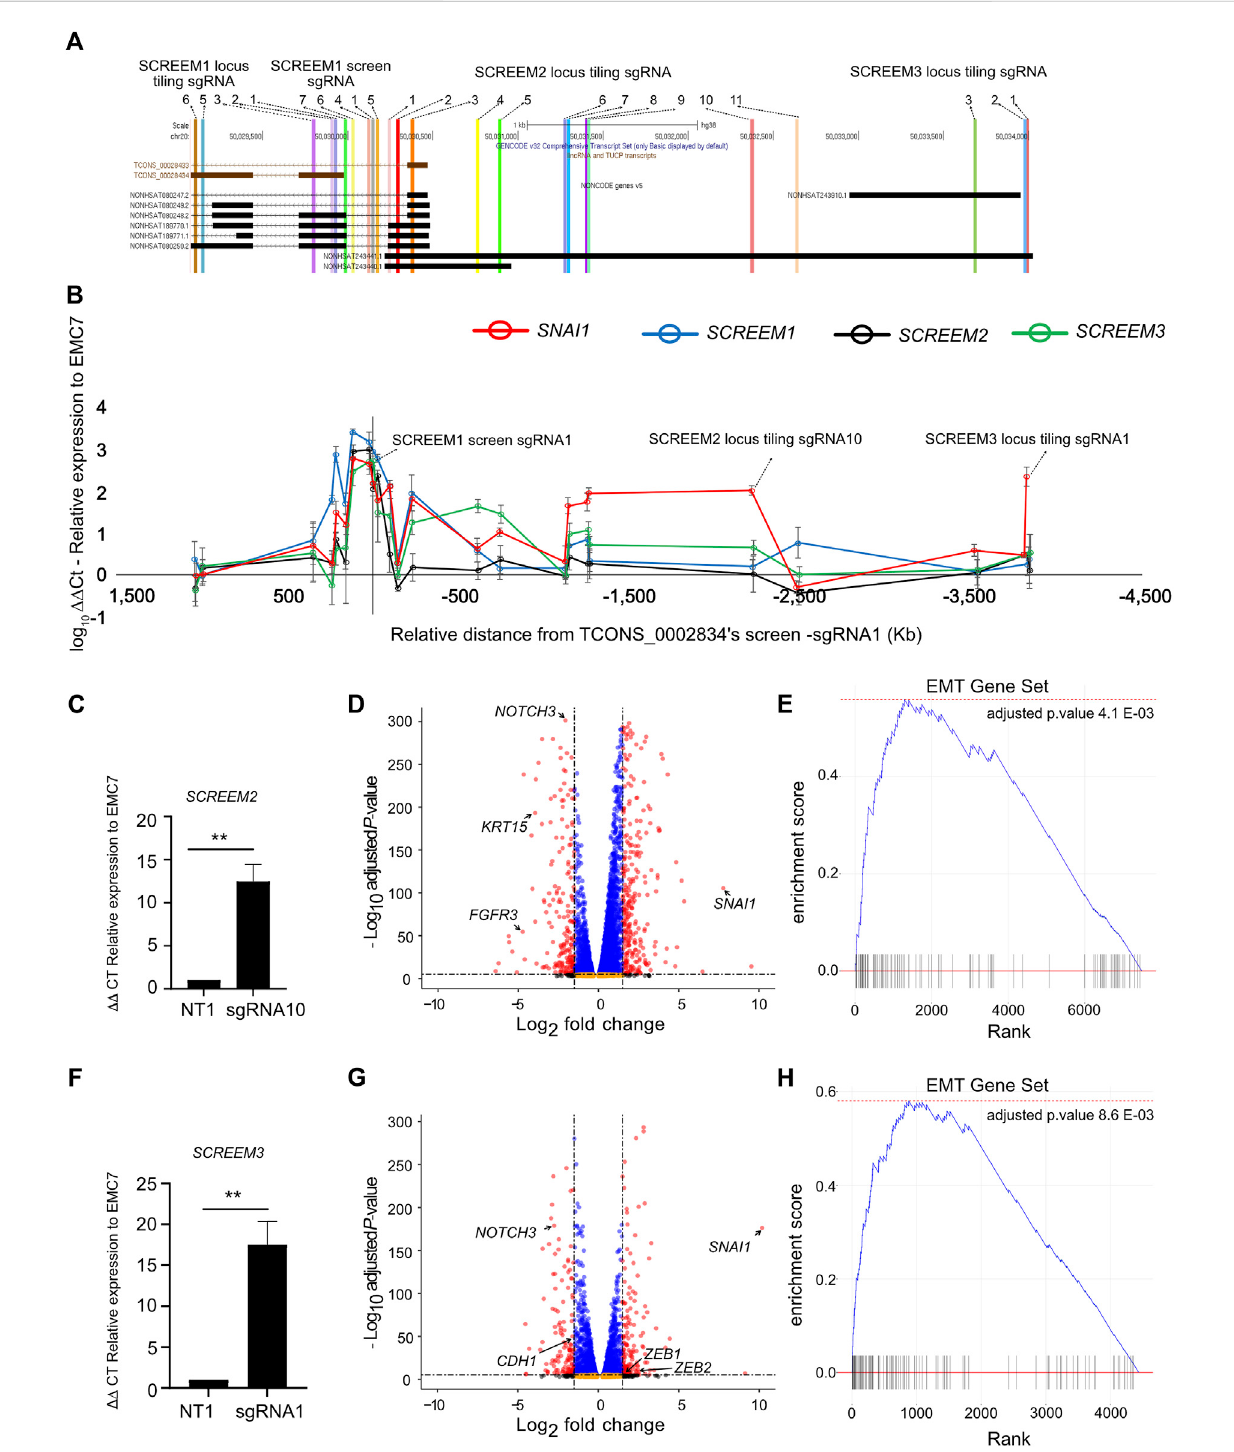
sgRNAtilingrevealsanextendedenhancer-likeregiondemarcatedbyeRNAlociwhichdrivesactivationof SNAI1 . (A) UCSCgenomebrowserviewof the SCREEM1 locus and its proximal genes. The location of different sgRNAs used are indicated . (B) RT-PCR analysis of SNAI1 , SCREEM1 , SCREEM2 , and SCREEM3 expression in HBEC3-KT cells upon CRISPR-activation using sgRNAs are shown. Plotted are log 10 delta-delta Ct values relative to NT and EMC7; NT, non-targeting. All values are mean ± SD with n = 3; (C) RT-PCR analysis showing expression of SCREEM 2 between NT-sgRNA and SCREEM 2 locus tiling-sgRNA10. Plotted are delta-delta Ct values relative to NT and EMC7; NT, non-targeting. All values are mean ± SD with n = 3; Stats, unpaired t -test,** p < 0.01. (D) Volcanoplotofexpressedgenes(TPM ≥ 1)betweenNT-sgRNAand SCREEM2 locustargeting-sgRNA10.NT,non-targeting, n = 3. Red dots, adjusted p -value < 10 – 6 and log2 fold change > 1; blue dots, adjusted p -value < 10 – 6 and log2 fold change < 1; black dots, adjusted p -value > 10 – 6 and log2 fold change > 1; orange dots, > 10 – 6 and log2 fold change < 1. (E) Ranked ordered gene set enrichment analysis of differentially expressed genes shown in (D) n = 3. (F) RT-PCR analysis showing expression of SCREEM3 between NT — sgRNA and SCREEM3 locus tiling — sgRNA1 in ( Continued